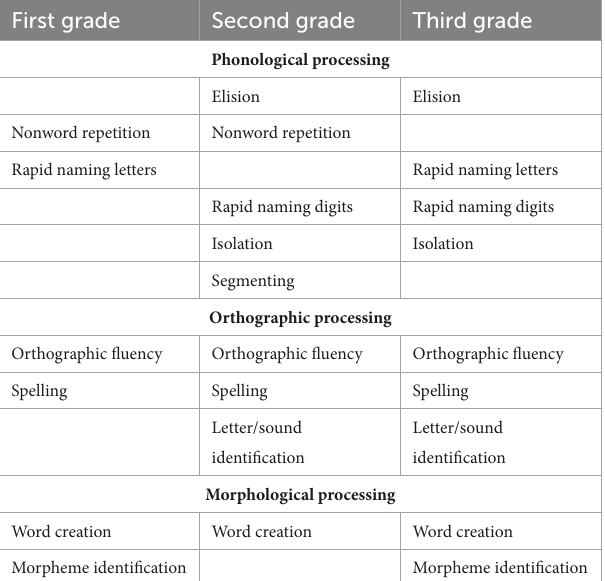
TABLE 9 Significant predictors of word reading fluency by grade